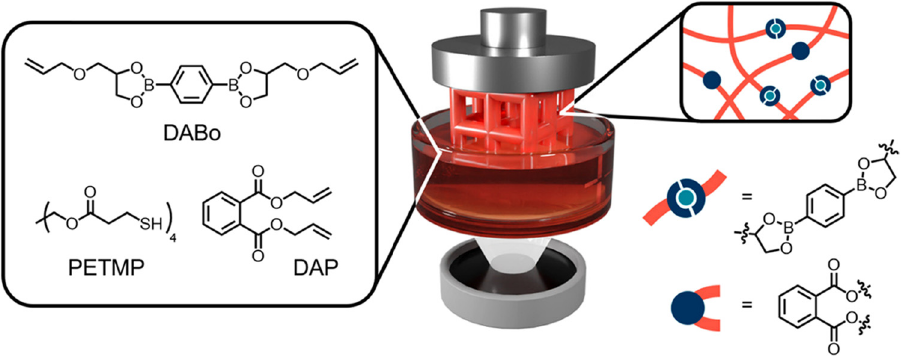
Figure 10: Overview of light - based 3D printing of resins, including dynamic boronate esters. Left: Monomers ( diallyl boronate ( DABo ) , PETMP, and diallyl phthalate ( DAP )) . Center: Graphical representation of a printer. Right: Schematic of the network structure containing a DABo ester and static DAP cross - links. Copyright 2021, American Chemical Society ( 121 )